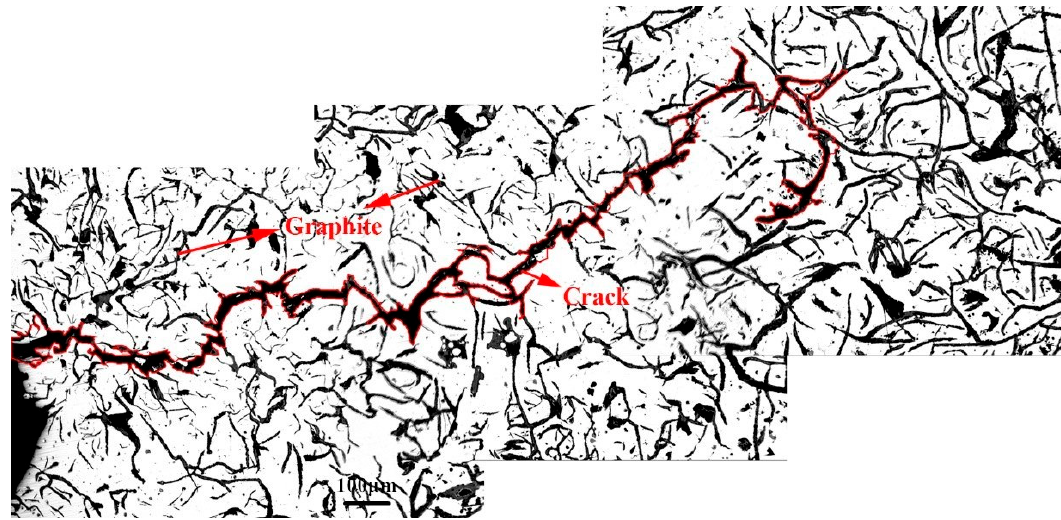
Figure 15. Micromorphology of macro thermal fatigue crack propagation.